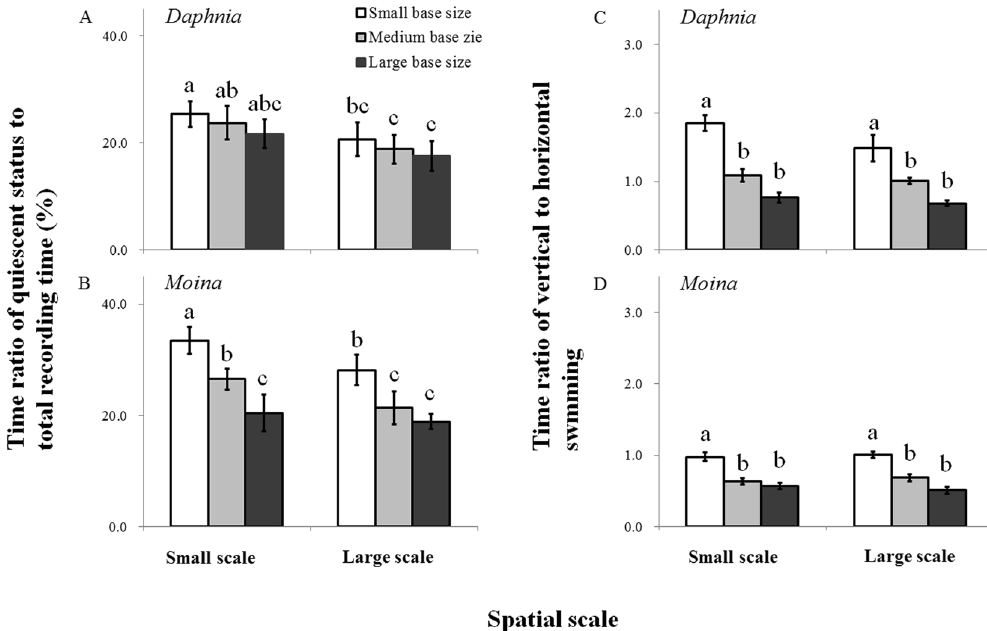
Figure 1. Time ratios (means ± 1 s.d., n = 6) of quiescent status to total recording time ( A , B ) and vertical to horizontal swimming ( C , D ) of grazer species ( Daphnia magna and Moina micrura with the green alga Chlorella pyrenoidosa as the exclusive diet) under three levels of habitat orientation and two levels of spatial scale. Different letters indicate significant differences among treatments. Multiple comparisons of means were performed using Tukey’s test at the 0.05 significance level. Figure 1 was created using Microsoft Excel